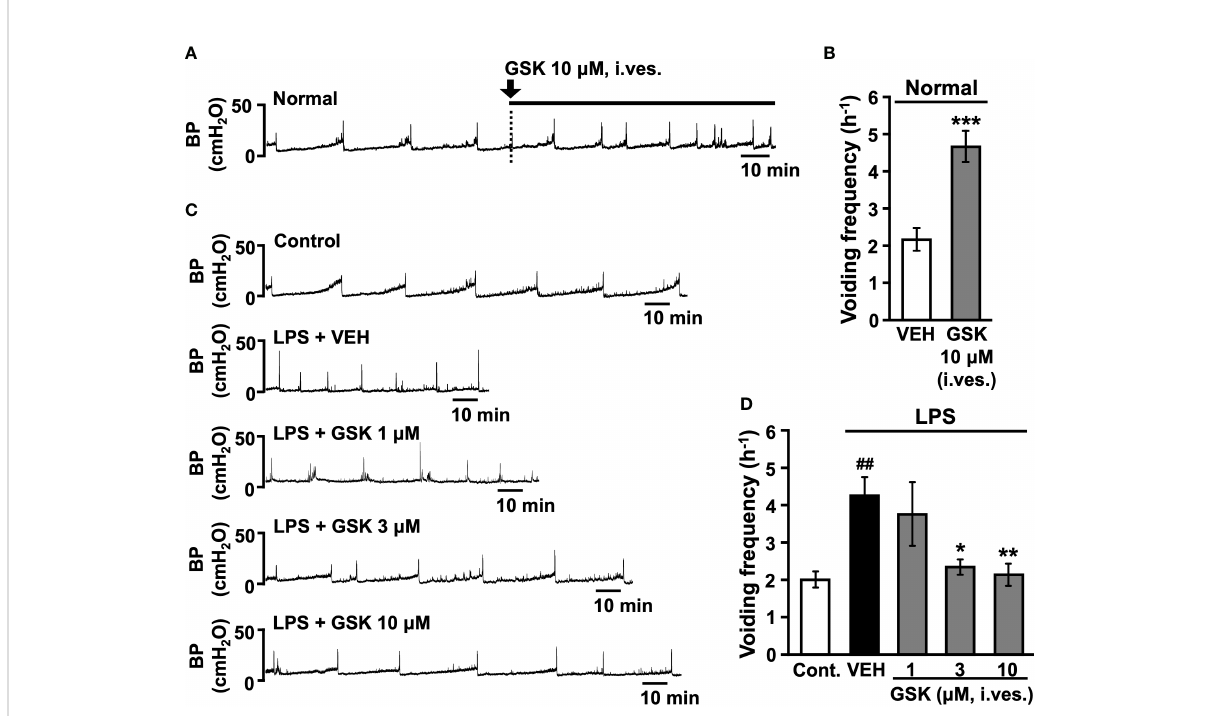
FIGURE 3 Effect of intravesical (i. ves.) instillation of GSK on normal or LPS-induced cystitis in conscious rats. (A) Representative continuous cystometrogram showing the effects of GSK bladder acute infusion in normal rats. (B) Changes in the voiding frequency of normal rats perfused with saline or GSK solution. (C) Representative continuous cystometrogram tracings from control, LPS- (LPS + VEH), and GSK-instillated group (LPS + GSK). (D) Changes in the voiding frequency in each group. Data represent the mean ± SEM from 5-8 rats. * P < 0.05, ** P < 0.01, *** P < 0.001 vs vehicle (VEH). ## P < 0.01 vs control. BP, bladder